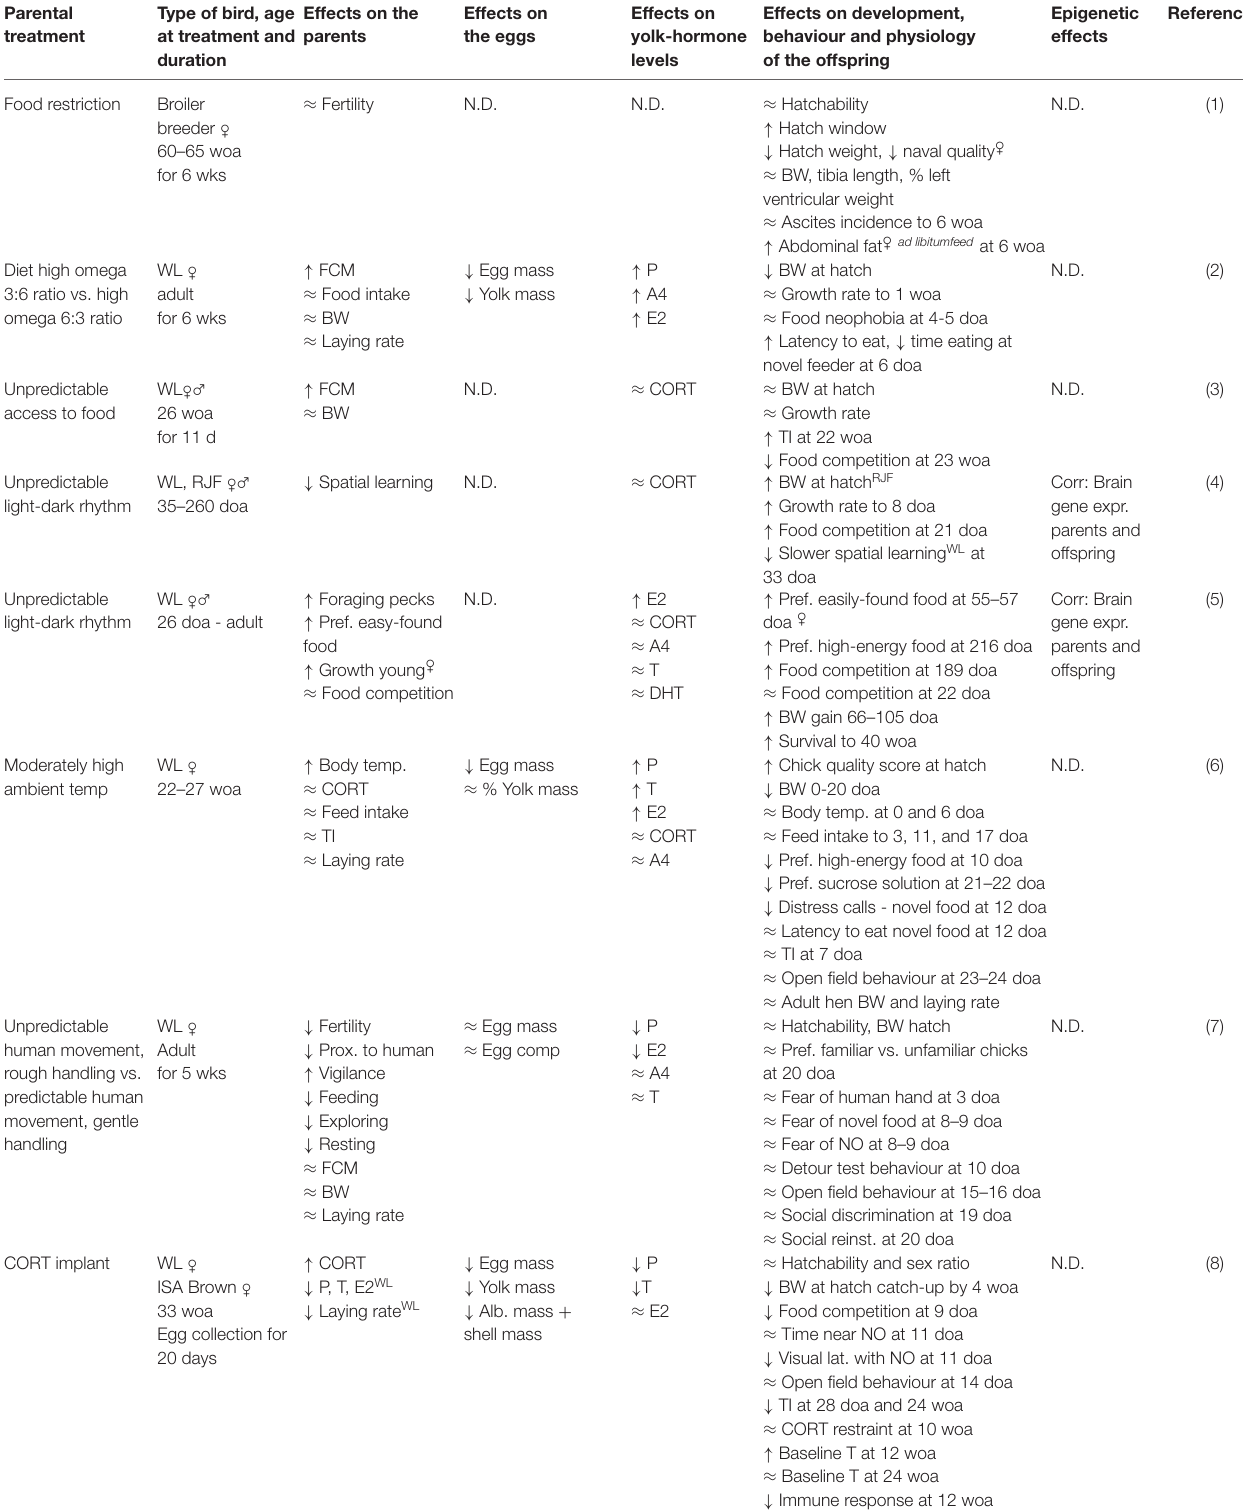
TABLE 1 | Examples of environmental effects on parents, their eggs, and their offspring in chickens. Parental Type of bird, age treatment at treatment